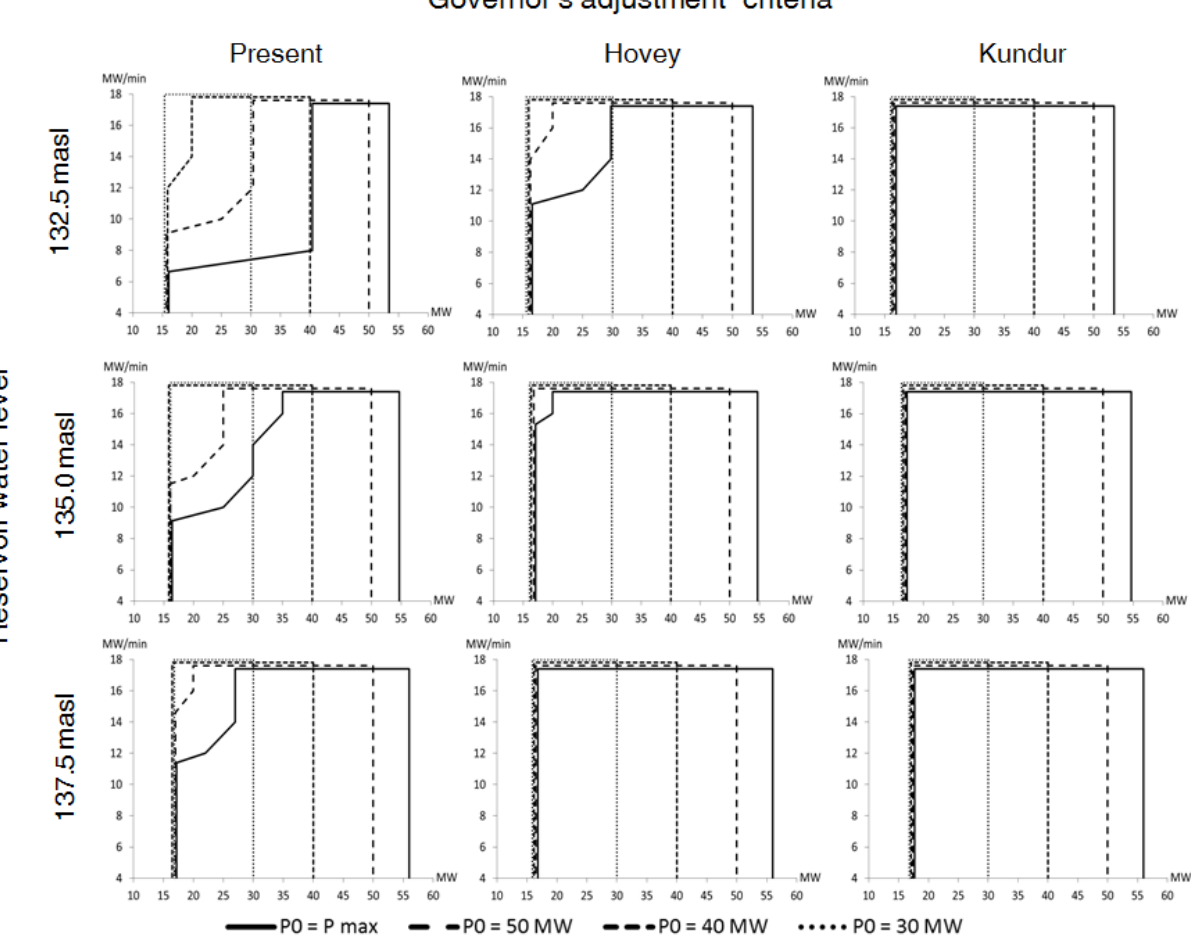
Figure 11. Ramp limits or maximum power bands for secondary load-frequency control (LFC), for different initial reservoir levels (132.5, 135, 137.5 masl), initial output powers (P0) and governor settings (Present, Hovey, Kundur).